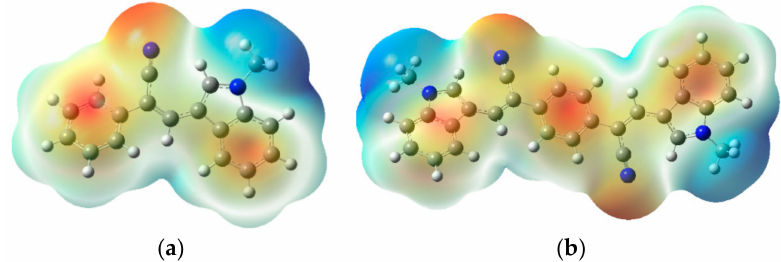
Figure 2. Molecular electronic potential diagrams of ( a ) AIE-1 and ( b ) AIE-2. Calculated by density functional theory (DFT) using B3LYP / 6-31G as the basis set.